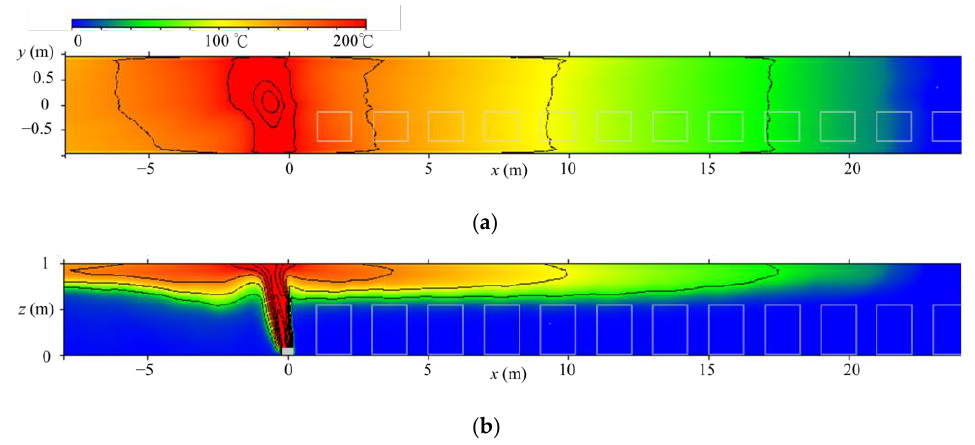
Figure 11. Simulated results of the temperature distribution in the central longitudinal section; Q m = 161 kW, U m = 0.421 m/s, t = 200 to 260 s: ( a ) z = 0.98 m; ( b ) y = 0.